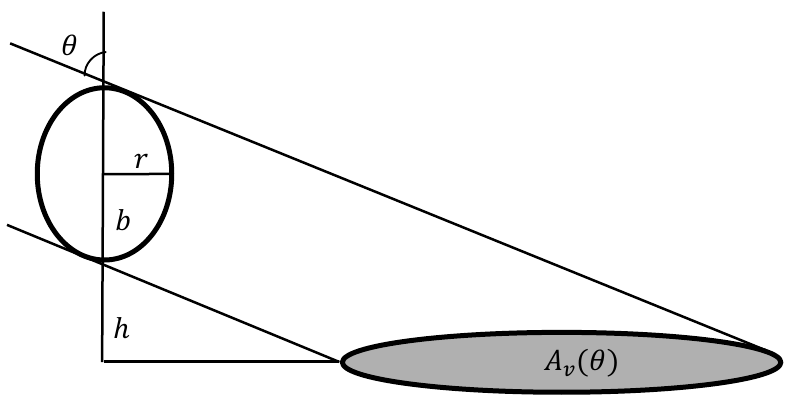
Figure 1. Geometry of a spheroid-on-a-stick, with three parameters: , stem height from ground to the bottom of crown, and and , the horizontal and vertical radius of the spheroid, redrawn from